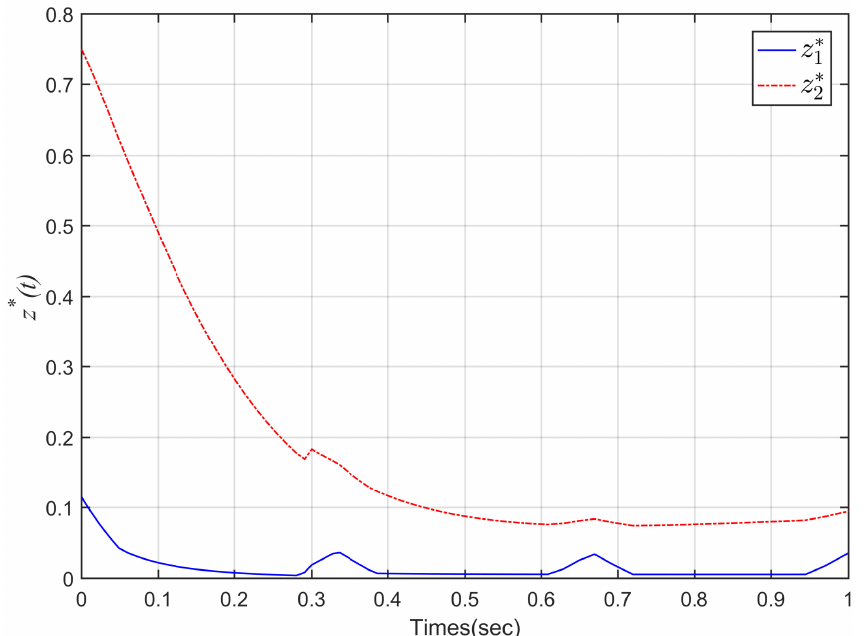
Figure 4. Output response z ∗ ( t ) for ω ∗ ( t )